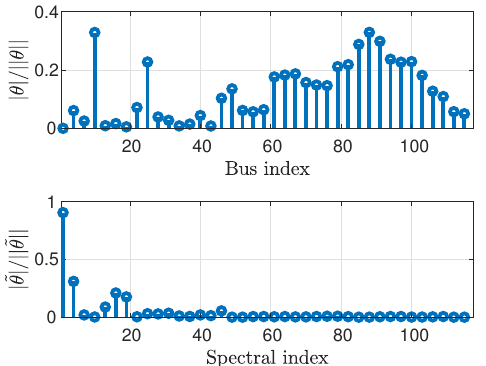
Figure 1. The state vector ( top ) and its GFT ( bottom ) for the IEEE 118-bus system.